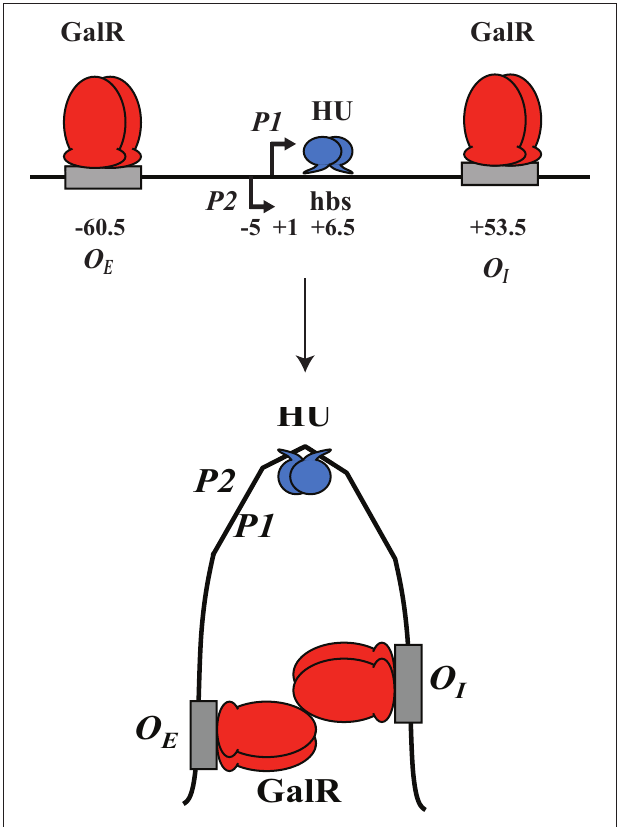
FIGURE 2 | DNA looping. GalR (red) binds to both O E and O I ; hbs reflects the HU binding site at position + 6.5. GalR- O E and GalR- O I interact, the intervening DNA loops out and forms a kink, while HU (blue) binds and stabilizes the loop.